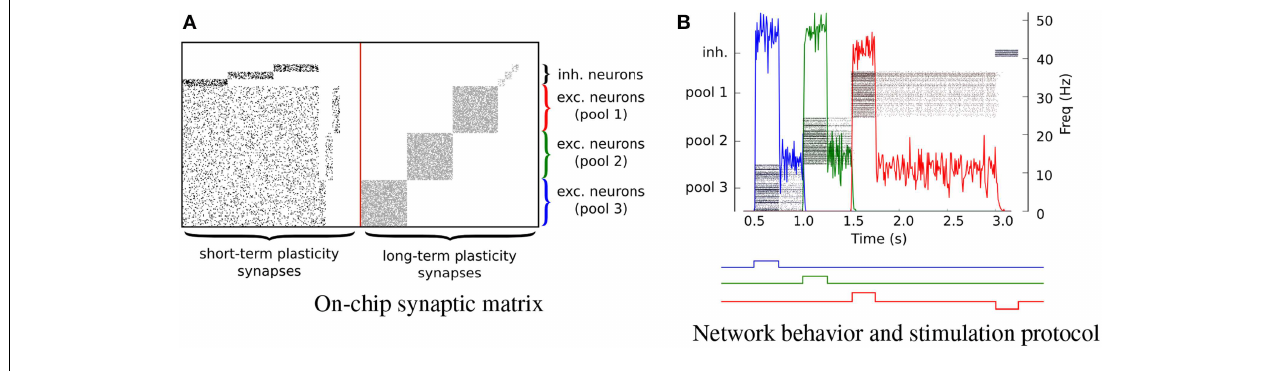
FIGURE 11 | Attractor networks. Three clustered pools of 64 neurons are configured as attractor networks. (A) The on-chip synaptic matrices in which every dot represents a connected synapse. (B) The output spiking activity of the network. Every pool of neuron is a competing